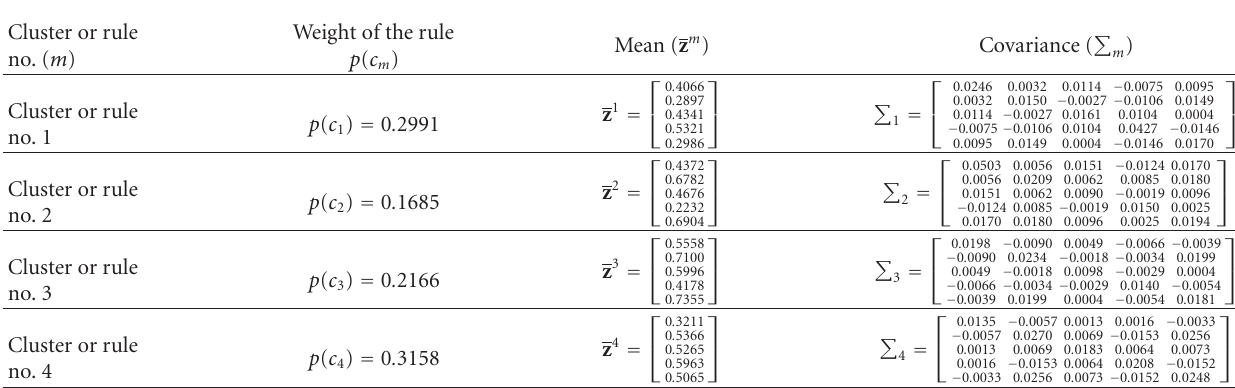
Table 1: Estimated parameters of A 4-component GMM using the EM algorithm.